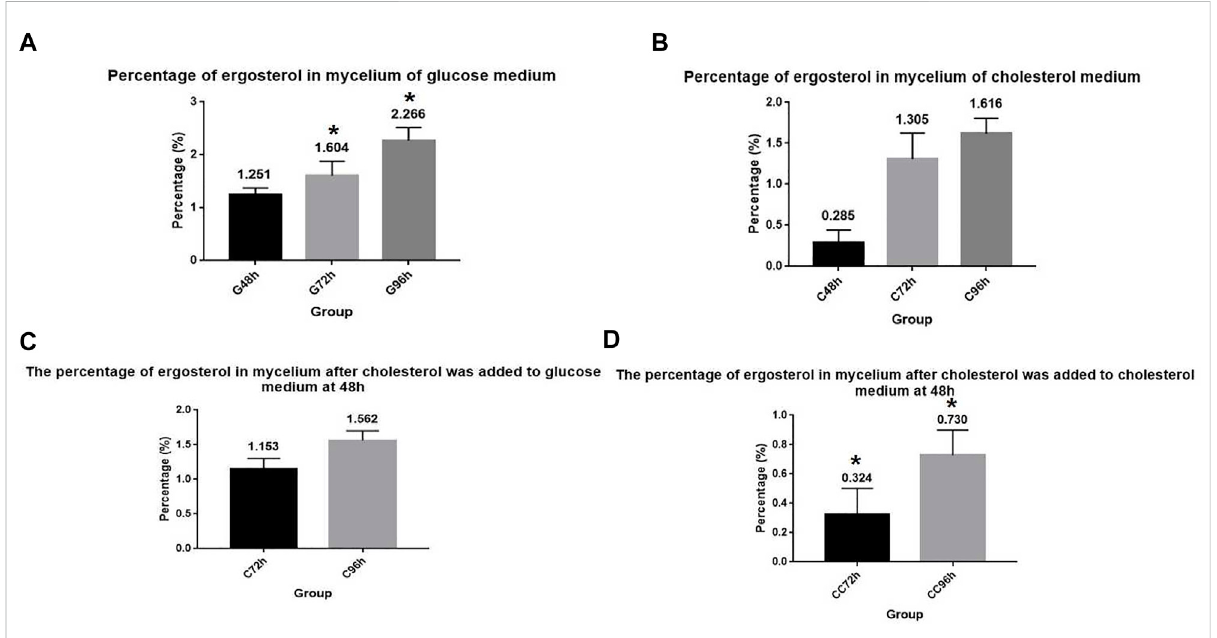
FIGURE 4 Cholesterolutilizationby A.oryzae canreduceergosterolcontentincells. (A) Glucosemediumwasfermentedby A.oryzae, andthepercentage ofergosterolinmyceliumdryweightat48,72,and96 hwasdetermined. (B) Cholesterolmediumwasfermentedby A.oryzae, andthepercentageof ergosterol inmyceliumdryweight at48,72,and 96 hwasdetermined. (C) Normalglucose medium wasfermented by A.oryzae and cholesterol was addedto themedium againat48 h. Thepercentageofergosterolinthemyceliumdry weight at72 hand96 hwasdetermined. (D) Cholesterol medium was fermented by A. oryzae and cholesterol was added to the medium again at 48 h. The percentage of ergosterol in the mycelium dry weight at 72 h and 96 h was determined. Three independent experiments were performed. The asterisk denotes statistically signi fi cant differences between the (A) and (D) at 72 h or 96 h based on Student ’ s t -tests (* p < 0.05).